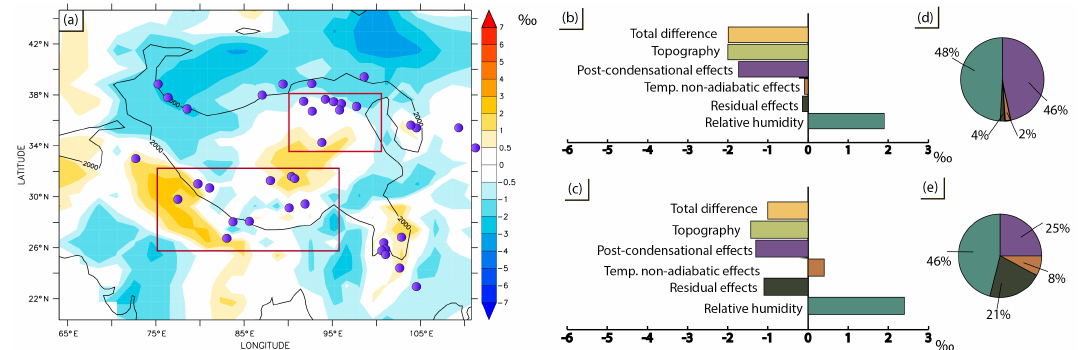
Figure 12. (a) Difference in δ 18 O p between INT and LOW experiments that is not related to direct effect of topography changes. Violet points show Cenozoic palaeoelevation study locations (compiled from Caves et al., 2015). Red rectangles show regions for that averaged values decomposed terms are shown: (b) northern region, (c) southern region. Pie diagrams show portion of total isotopic difference related to processes other then topography: (d) northern region, (e) southern region.